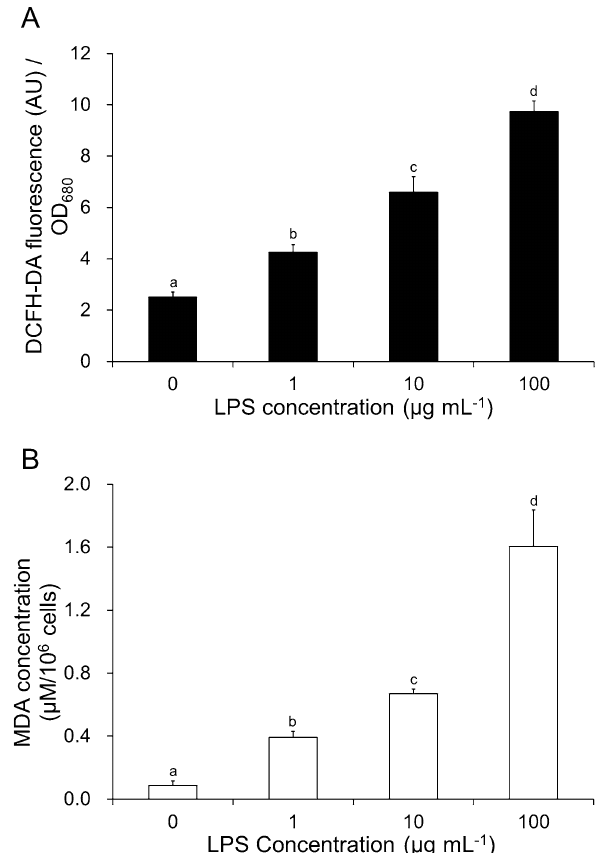
Figure 4. Effect of lipopolysaccharide (LPS) supplementation on the levels of cellular reactive oxygen species (ROS) ( A ) and lipid peroxidation (malondialdehyde content) (MDA) ( B ) of Chlorella vulgaris OW-01. ROS was detected by 2,7-dichlorodihydrofluorescein diacetate (DCFH-DA) staining-mediated fluorescence at an excitation wavelength of 485 nm and an emission wavelength of 535 nm. Scale bar, 10 µm. Error bars represent the mean ± standard deviation (SD) from triplicate experiments. Different letters represent significant difference ( P <